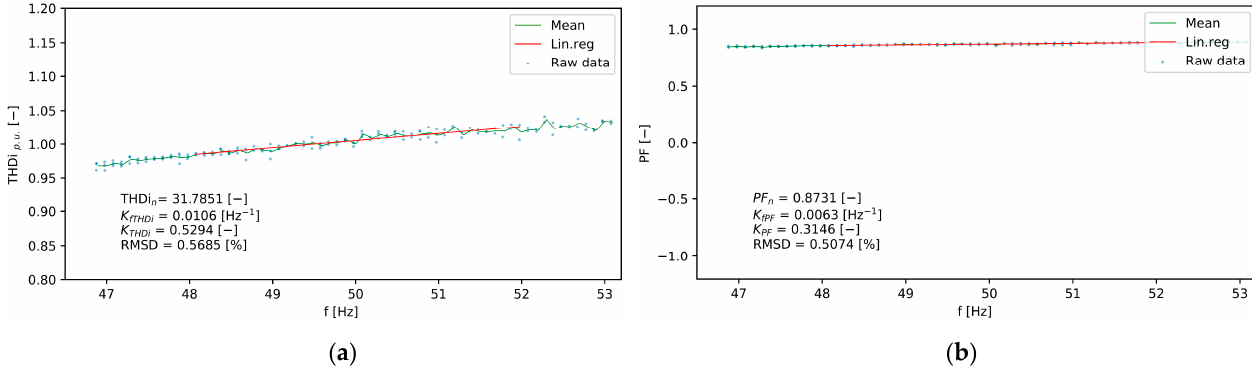
fTHDi , K THDi ; ( b ) K fPF , K PF